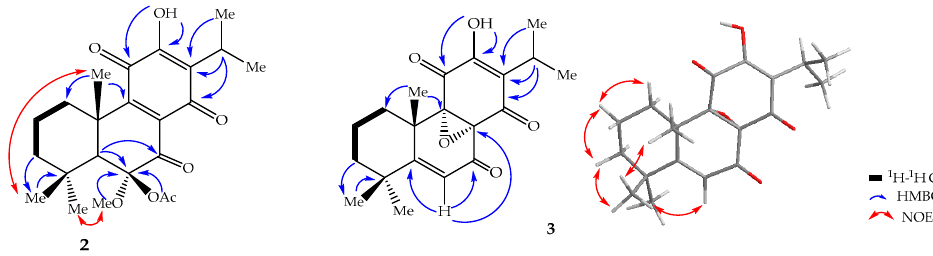
Figure 4. Key 1 H– 1 H COSY (bold lines); HMBC (blue arrows) and NOE (red arrows) correlations of 2 and 3 .